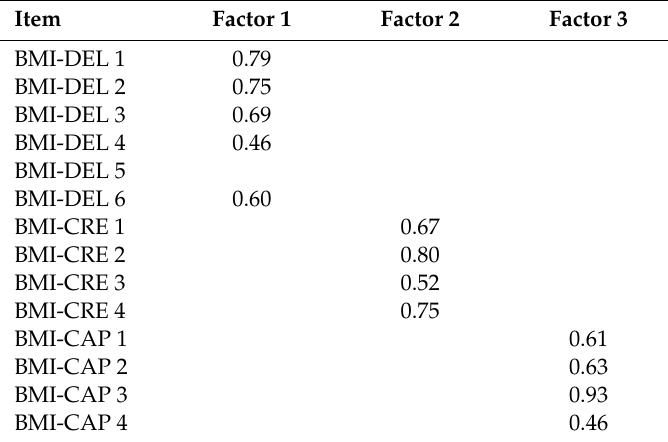
Table 2. Exploratory factor analysis for